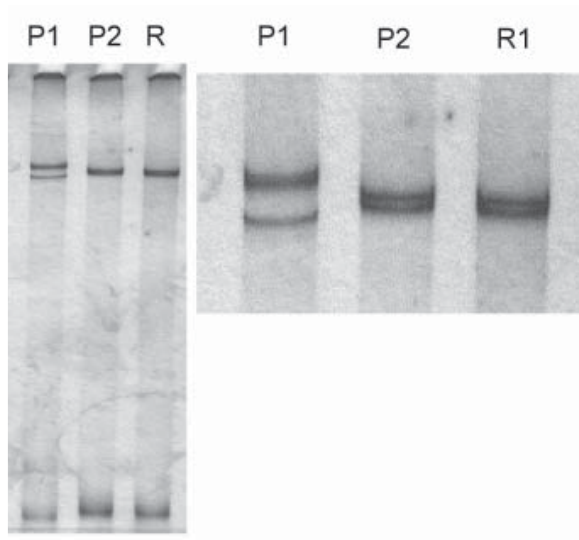
Fig. 1. Single-stranded conformation patterns of IC/RT- PCR fragments containing the coat protein gene. Bot- tom bands on the left side panel correspond to ds-DNA. Upper bands correspond to ss-DNA. The picture on the right is a magnification of the ss-DNA region.